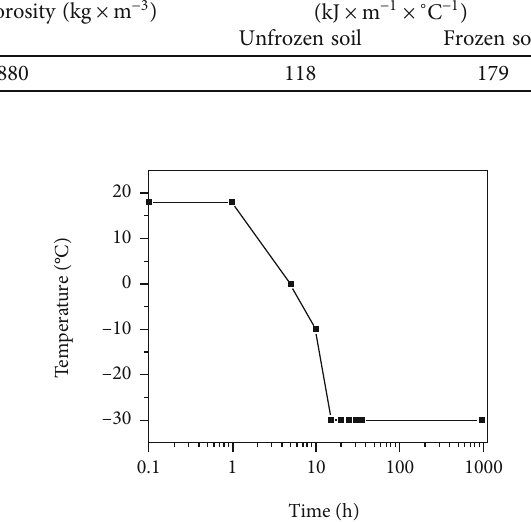
Figure 4: The applied boundary temperature curve.